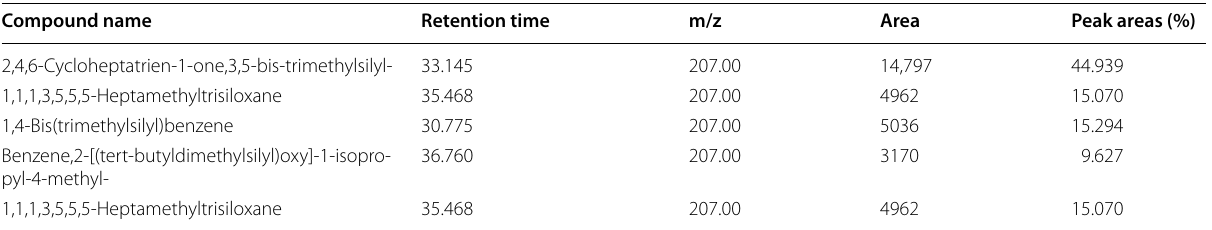
Table 1 Quantitative compounds identified from W. edulis methanol stem extract by GC–MS analysis Compound